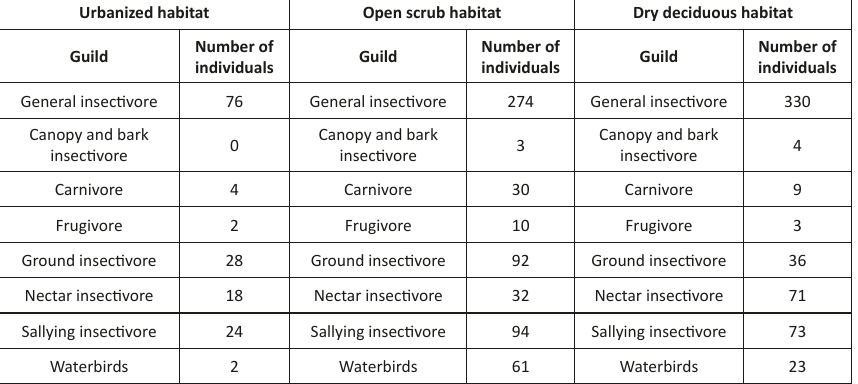
Table 5. Guild wise distribution of birds among different habitats in IIFM campus Urbanized habitat